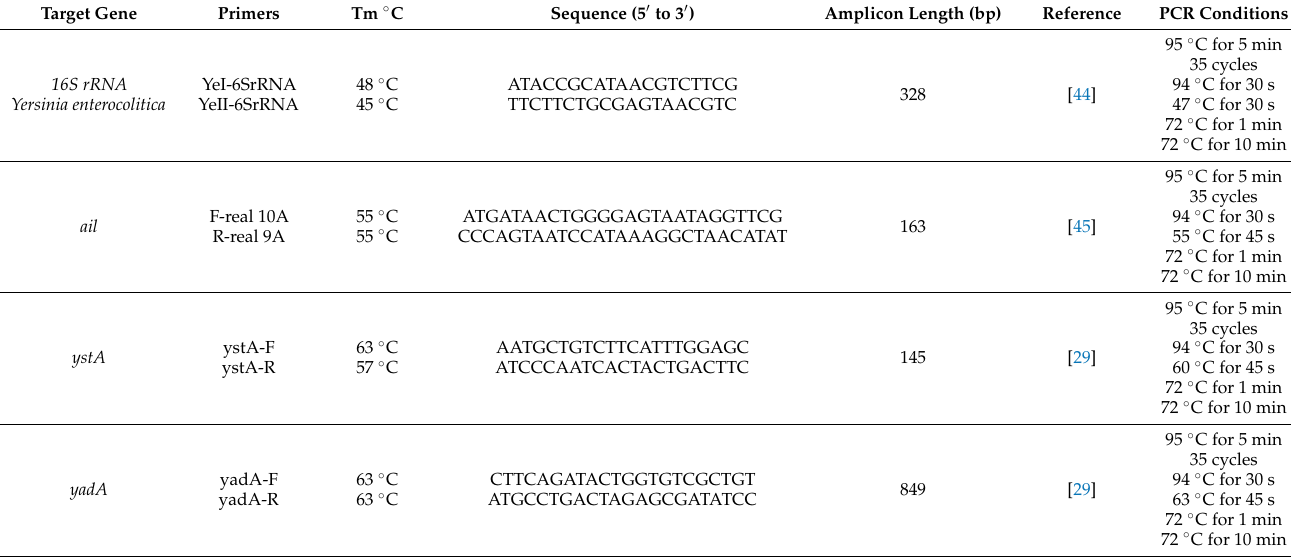
Table 2. Primers are used for PCR